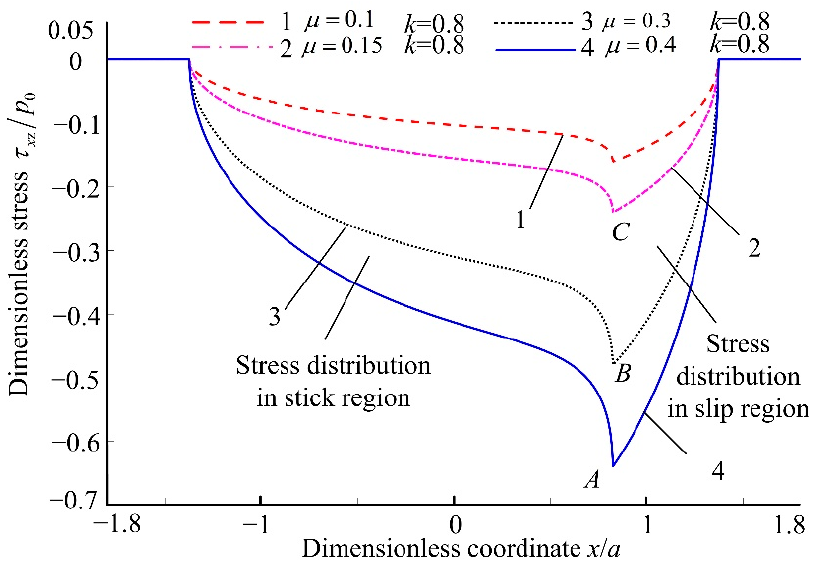
Figure 11. Stress τ xz / p 0 for different values of µ.